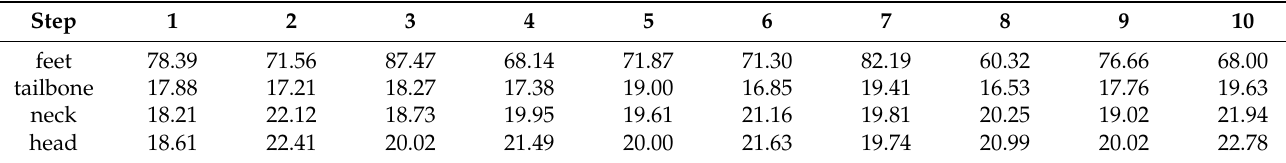
Table 2. Top acceleration: bare feet [m/s 2 ]. Table 3. Top acceleration: sport shoes [m/s 2 ].